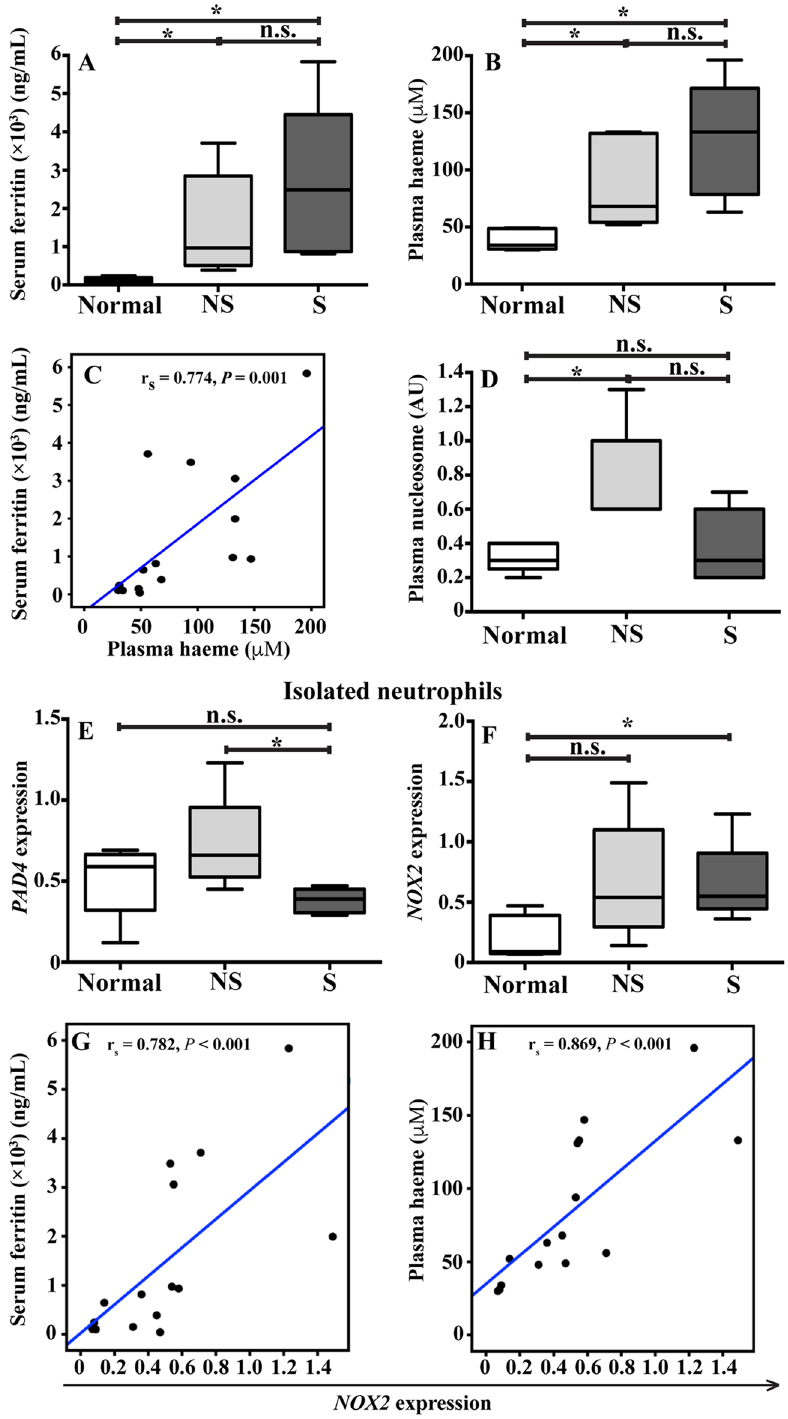
Figure 1. Iron overload and NET markers in β-thalassaemia/HbE. Blood samples were collected from 5 normal subjects (N), 5 non-splenectomised β-thalassaemia/HbE patients (NS) and 5 splenectomised β-thalassaemia/HbE patients (S) to determine ( A ) serum ferritin (immunoenzymatic kit, DiaMetra) and ( B ) plasma haeme (haeme assay kit, Sigma-Aldrich). ( C ) Spearman’s rank correlation coefficient analysis between serum ferritin and plasma haeme. ( D ) Plasma nucleosomes were determined using the cell death detection ELISA PLUS kit (Roche Diagnostics GmbH). The expression of ( E ) PAD4 and ( F ) NOX2 mRNA expression in isolated neutrophils from those subjects was determined using RT-qPCR. GAPDH was used to as normalizer to calculation of the relative quantification by 2 (−ΔCt) method. Spearman’s rank correlation coefficient analysis between NOX2 expression in isolated neutrophils and ( G ) serum ferritin or ( H ) plasma haeme. n.s.; no significant difference, *; significant difference at P < 0.05 using a non-parametric Mann–Whitney U